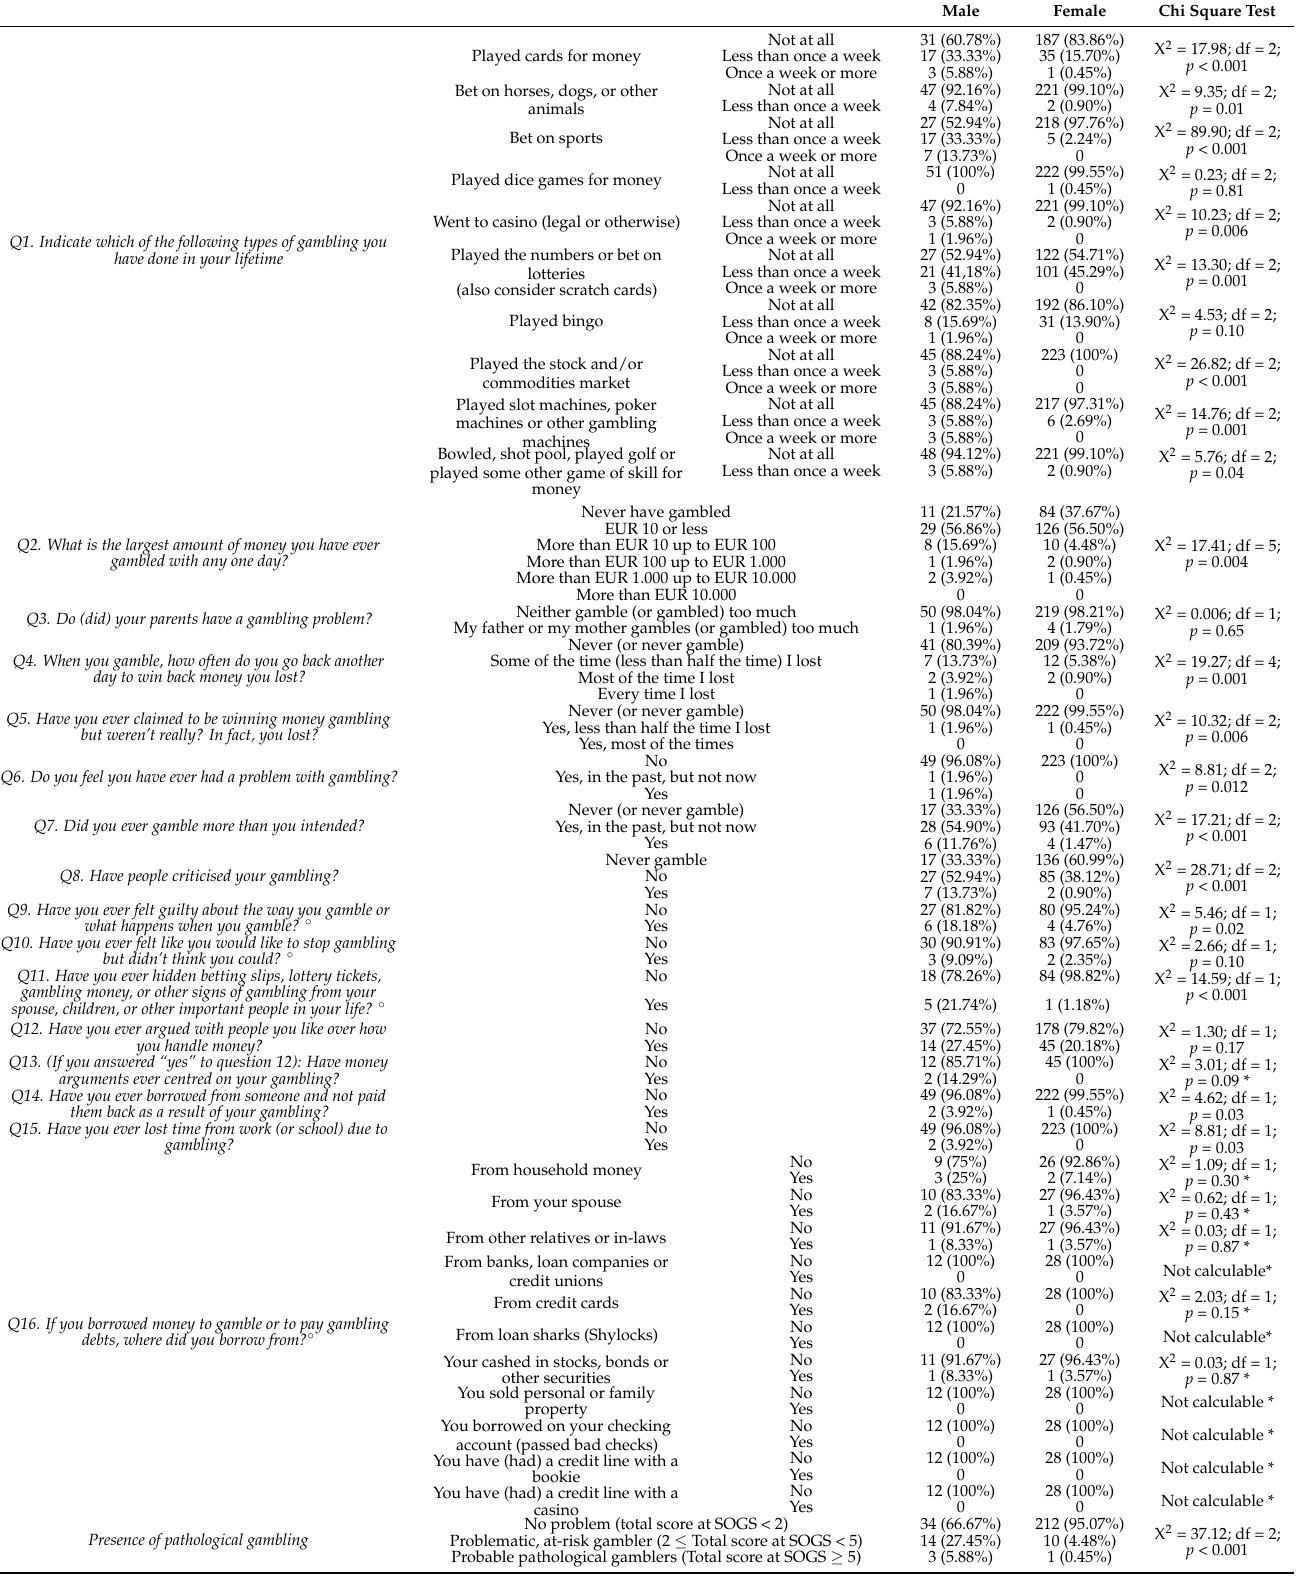
Table 3. Differences in responses to SOGS between the male and female